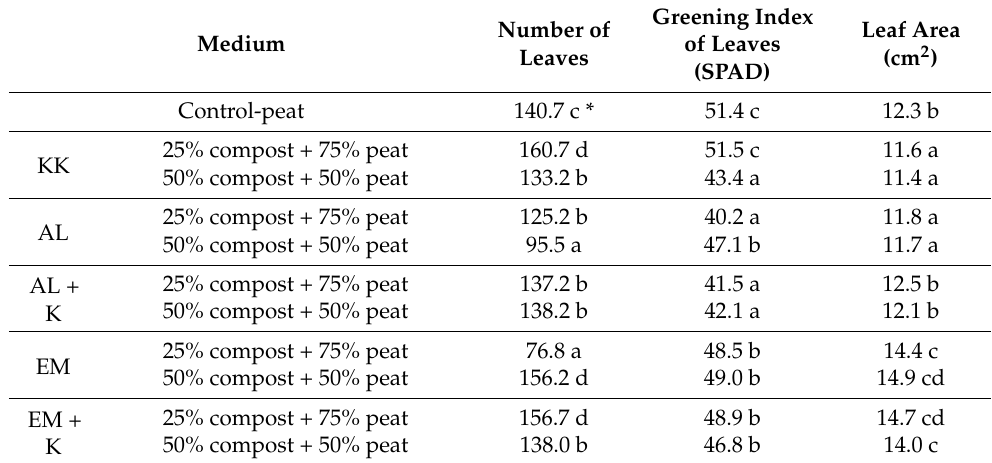
Table 7. The influence of medium on vegetative features of